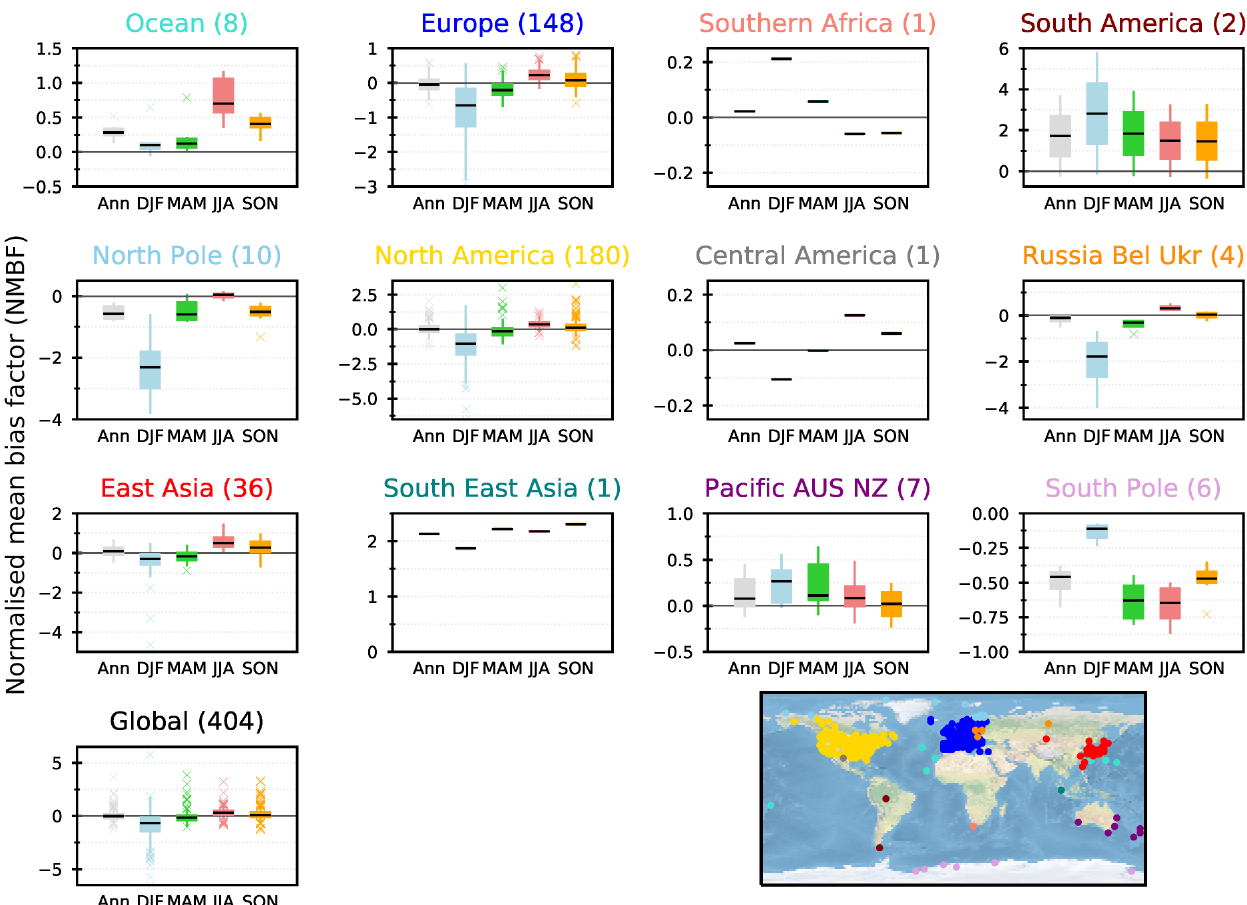
Figure 6. Normalised mean bias factors (NMBFs) calculated for annual and seasonal means by comparing modelled concentrations of surface O 3 in the UKESM1 ND simulations to gridded observations from the TOAR database across each region over the 2005–2014 period. The solid line shows the median value for the region, the boxes show the 25th and 75th percentile values (Q1 and Q3), with the error bars extending from the boxes to cover the main body of the data from (Q1 − 1.5IQR) to (Q3 + 1.5IQR) (IQR: interquartile range), and crosses represent outliers (values > 1.5 × interquartile range). The total number of sites used for each region is shown in parenthesis. Comparisons on annual (grey), DJF (blue), MAM (green), JJA (red) and SON (orange) timescales are shown.